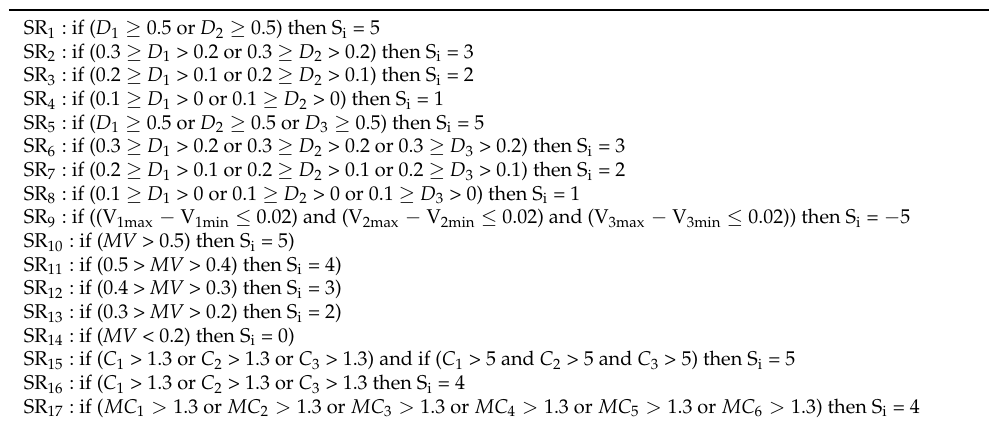
Table 2. Rules of the scoring